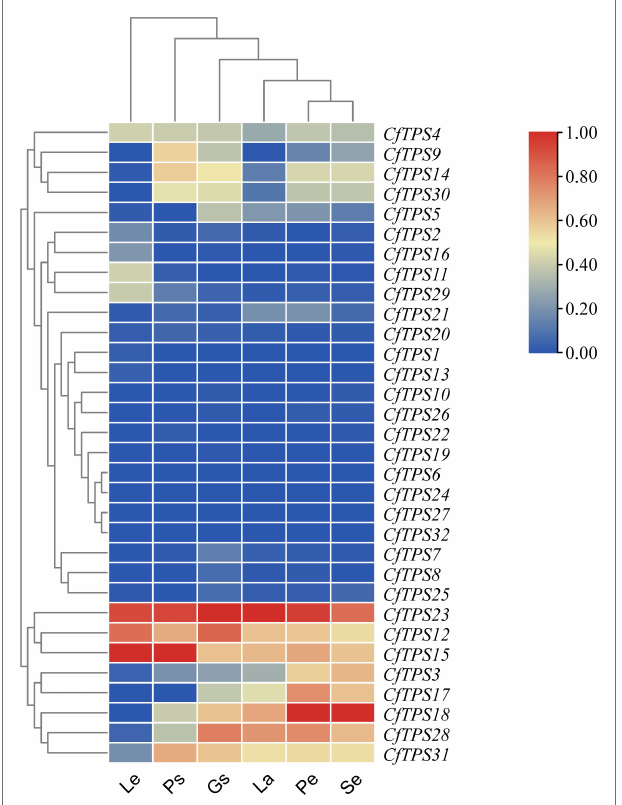
FIGURE 6 | Expression patterns of CfTPS genes in different organs. The heatmap was produced in Tbtools (Chen et al., 2018). The tissues were leaves (L), pseudobulbs (Ps), petals (Pe), sepals (Se), labellum (La), and gynostemium (Gs) in wild C. faberi . The fragments per kilobase of transcript per million fragments (FPKM) values are listed in Supplementary Table S9